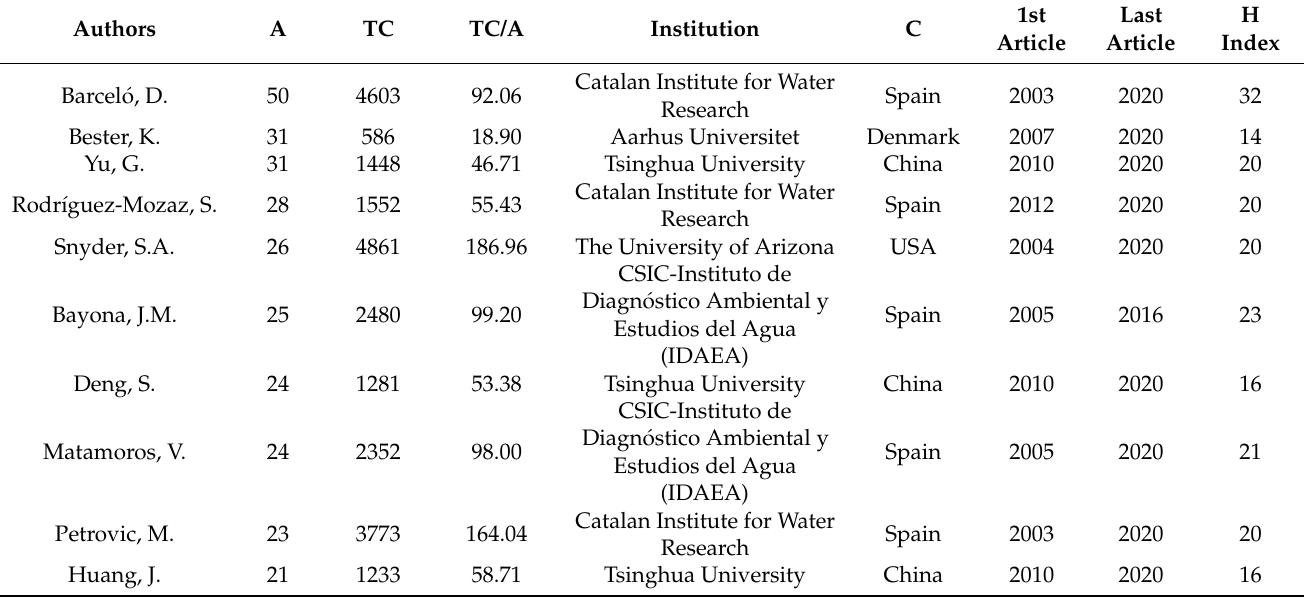
Table 5. Most prolific authors from 1979 to